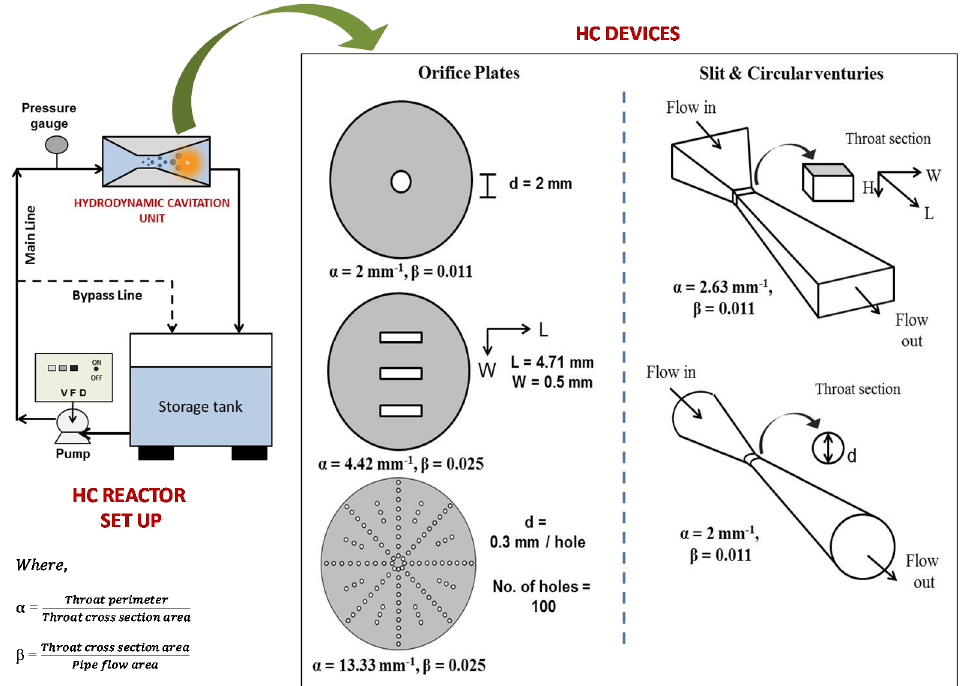
Figure 1. Schematic of the hydrodynamic cavitation (HC) reactor setup and hydrodynamic cavitating devices based on venturi and orifice plate (non-rotating) (reproduced with permission from Carpenter et al. 2017 [8] and Bargole et al. 2019 [9]).